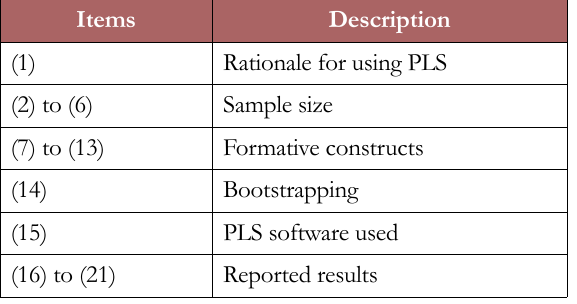
Table 1. Number of items reviewed (Peng & Lai,